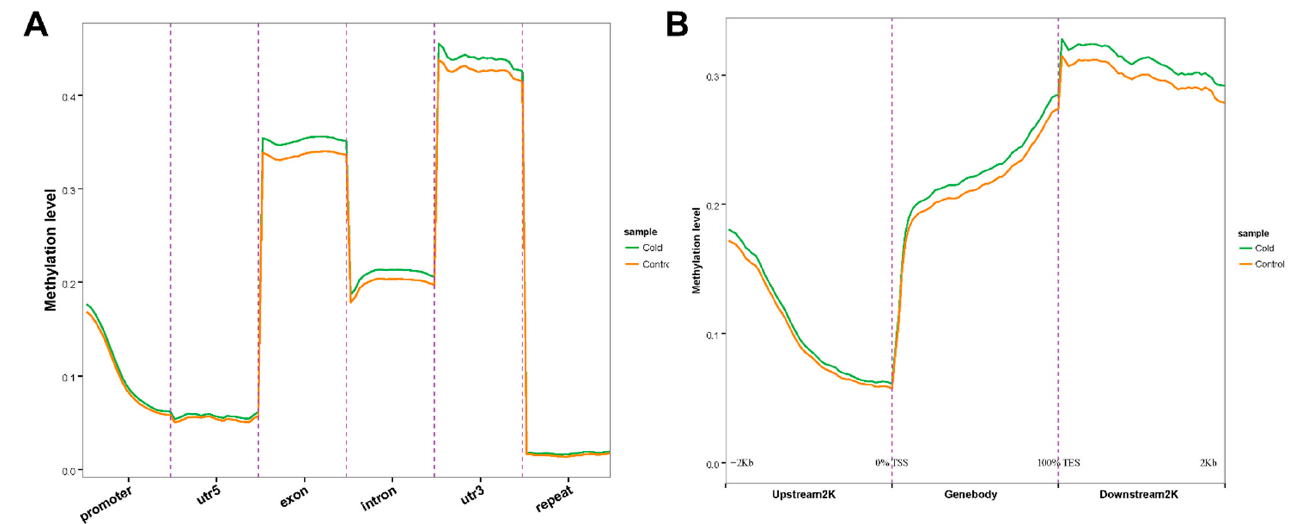
Figure 2. DNA methylation profiles of H . longicornis adults at different genomic functional rgions. ( A ). Distribution of the methylation level of functional regions between the control and low-temperature mCG/CG. ( B ). Distribution of methylation level of genes upstream and downstream between the control and low-temperature mCG/CG. TSS: transcription start site, TES: transcription end site.